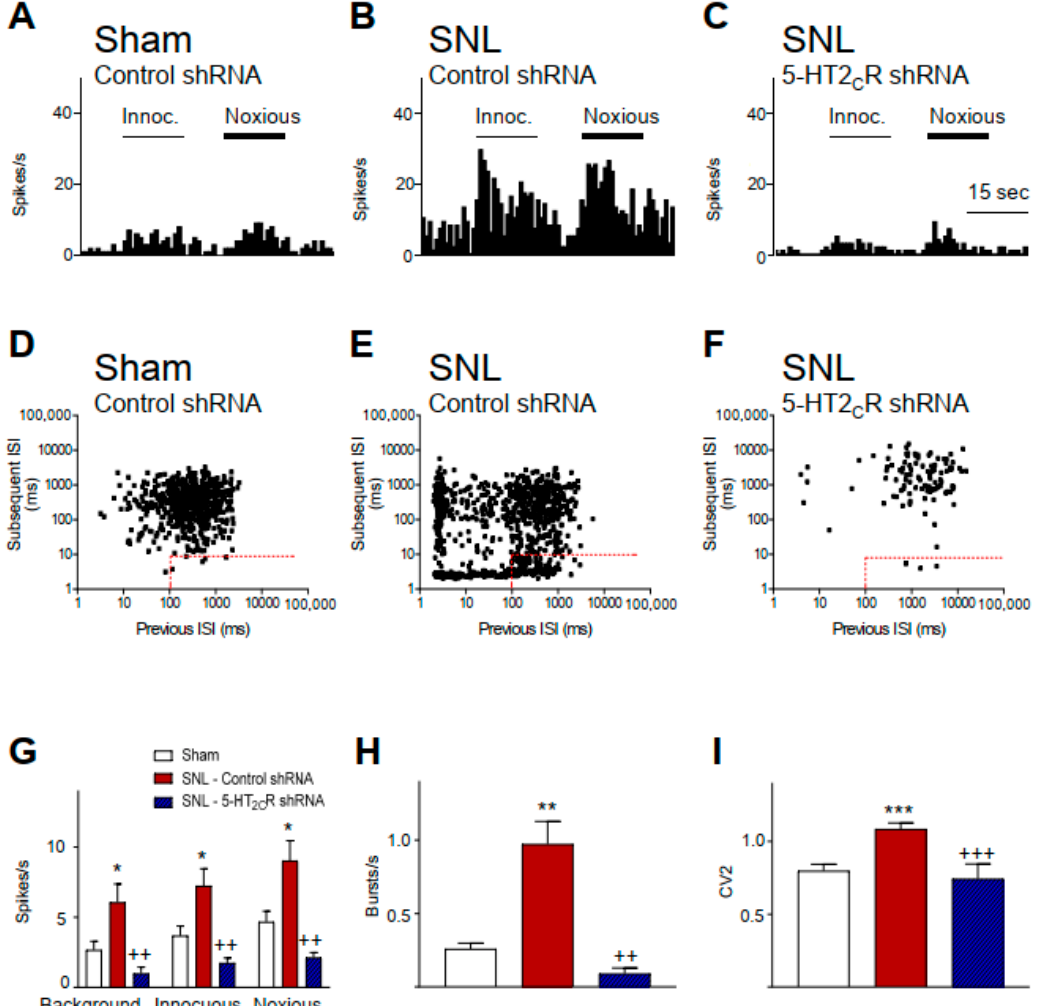
Figure 2. 5-HT 2C R knockdown in the basolateral amygdala (BLA) inhibits CeA neuronal activity in a neuropathic pain model. ( A – C ) Examples of individual CeA neurons (three di ff erent neurons). Peristimulus time histograms (PSTHs) show the number of action potentials (spikes) per second. Innocuous and noxious stimuli (compression of the hindpaw for 15 s) are indicated by horizontal lines. ( D – F ) Joint interspike interval (ISI) plots (previous ISI against the subsequent ISI) detected burst activity, indicated by the rectangular insets (dots within the dashed red lines represent the first spike in a burst). Examples of individual CeA neurons (three di ff erent neurons). ( A , D ) CeA neuron recorded in a sham rat injected with control vector into the BLA. ( B , E ) CeA neuron in an SNL rat with control vector injected into the BLA. ( C , F ) CeA neuron in an SNL rat with 5-HT 2C R knockdown in BLA. ( G – I ) Bar histograms showing mean ± SE for the sample of neurons. ( G ) Background activity and net evoked responses to innocuous and noxious stimuli increased significantly in (control vector treated) SNL